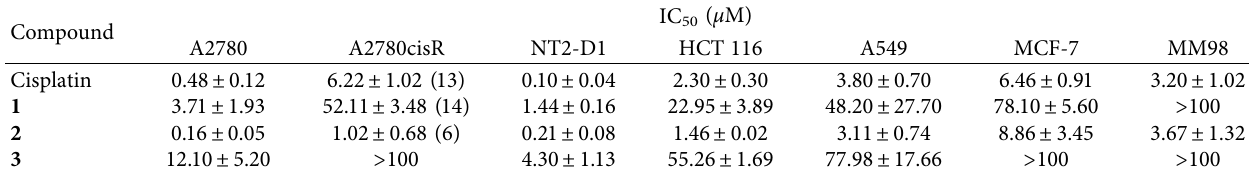
Table 2: Antiproliferative data (IC 50 , μ M) for Complexes 1 – 3 obtained after 72h of treatment. Data in brackets represent the resistance factor, RF � IC 50 A2780cisR (cisplatin-resistant)/IC 50 A2780 (wild-type), rounded to the nearest unity. Data are the mean ± standard deviation (sd) of at least three replicates.